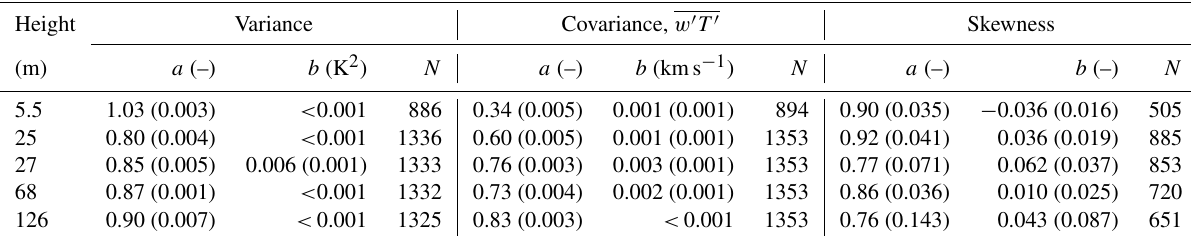
Figure 5. Comparison of DTS and 3D sonic anemometer (REF) 30min values for temperature variance (a, d) , w (cid:48) T (cid:48) covariance (b, e) and skewness (c, f) at two different heights on the mast. Upper panels (a–c) show below-canopy heights (0.3 h c ) and lower panels (d–f) show above-canopy heights (1.6 h c ). For skewness, only periods with SNR > 0.5 (Eq. 13) were used, otherwise all available data were included. Coefficients related to the linear fits are given in Table 2. Colour denotes the density of the point cloud. Note that no corrections for sensor separation effects (Horst and Lenschow, 2009) or signal attenuation (Sect. 3.2) were made prior to comparison. Table 2. Linear regression statistics between DTS and 3D sonic anemometers at different heights ( y = ax + b , where y equals DTS, and x is a 3D sonic anemometer). The fits between data sets were performed using robust regression in order to minimise the effect of outliers on the regression coefficients. Standard errors for the coefficients are given in parentheses, and N shows the number of 30min data points used in the fit. For skewness, only periods when the signal-to-noise ratio for DTS data was above 0.5 were utilised; for other statistics, all available data were used. Note that no corrections for sensor separation effects (Horst and Lenschow, 2009) or signal attenuation (Sect. 3.2) were made prior to